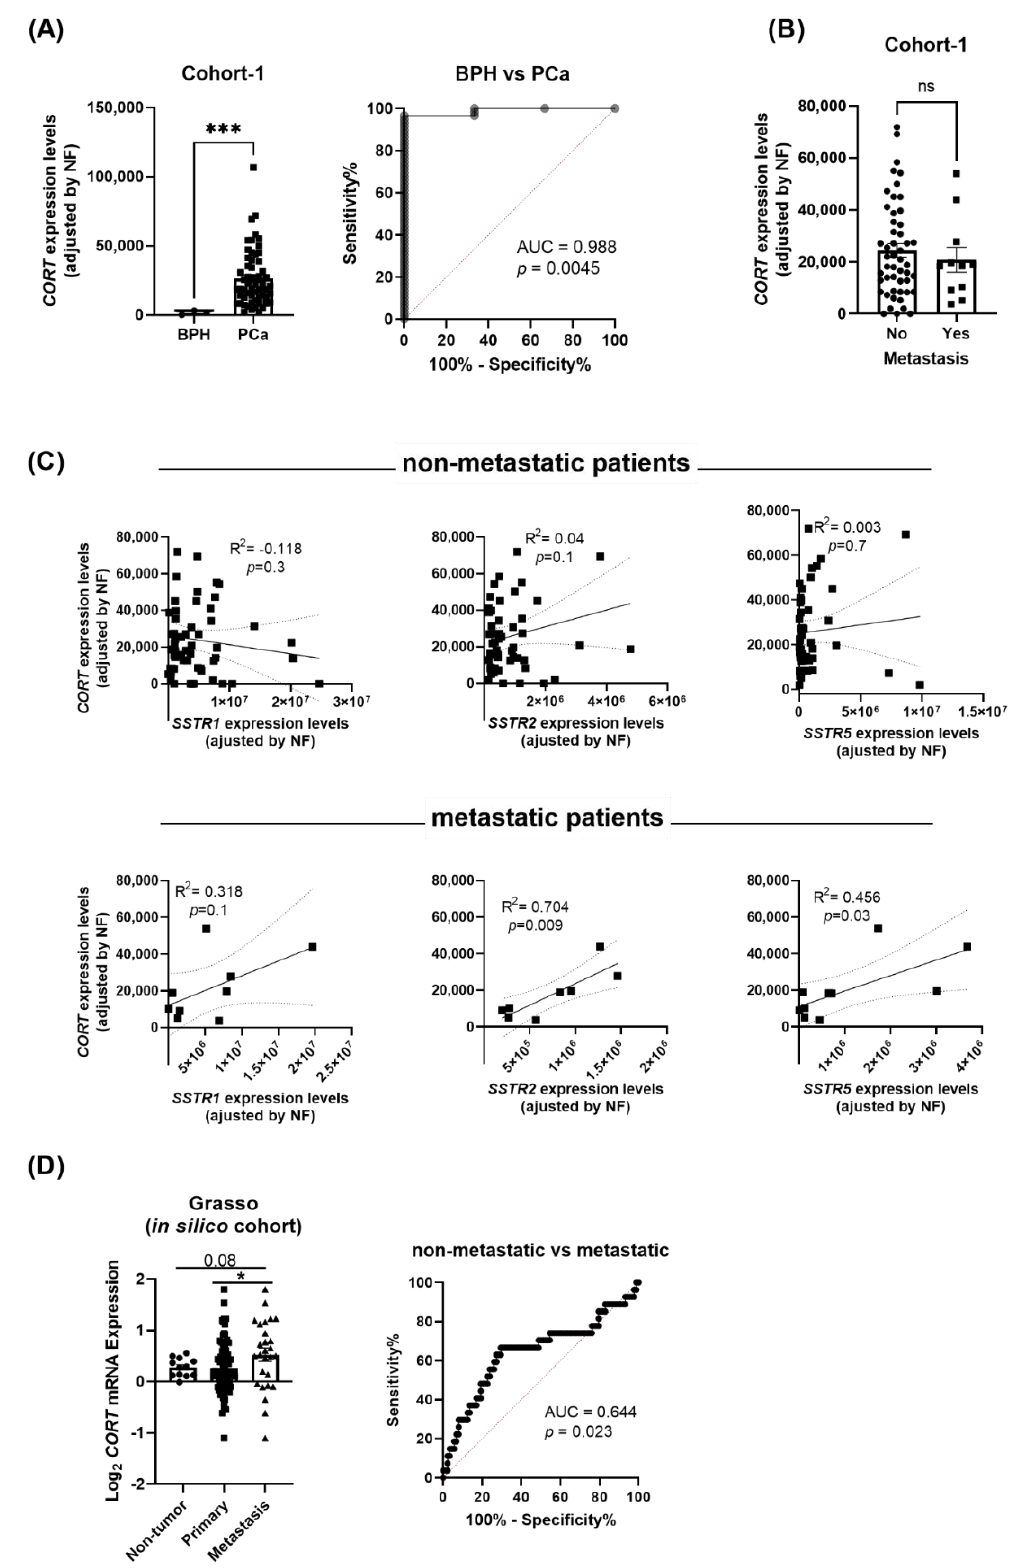
Figure 4. Expression levels of cortistatin (CORT) in prostate tissue. ( A ) Comparison of CORT ex- pression levels between benign prostatic hyperplasia (BPH) and prostate cancer (PCa) samples (co- hort-1). ROC curve analysis comparing CORT expression in PCa vs. non-tumor BPH tissues, and associated AUC, is also indicated. ( B ) Comparison of CORT expression between primary tumors obtained from patients with metastasis vs. those without metastasis. ( C ) Correlation between CORT- expression and SSTR1, SSTR2, and SSTR5 expression in primary tumors obtained from patients without and with metastasis (cohort-1). ( D ) Comparation of CORT expression between non-tumor, primary tumor and metastatic samples obtained from the Grasso in silico cohort. ROC curve